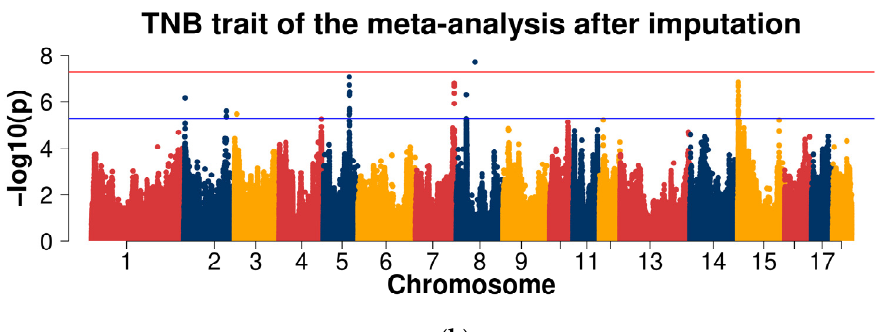
( h ) Figure 2. The Manhattan plots of association results of different populations for the total number born (TNB) trait using chip data ( a – d ) and imputed WGS data ( e – h ). ( a , e ) Canadian line; ( b , f ) French line; ( c , g ) combined lines of Large White pigs; ( d , h ) cross-population meta-analyses. Table 2. The significant and suggestive SNPs in the genome with the total number born (TNB), number of stillborn (NSB), and gestation length (GL) traits using chip data in pigs. SNP Position Candidate p (Canadian) p (French) p (Combined LW) p (Meta) (bp) Gene